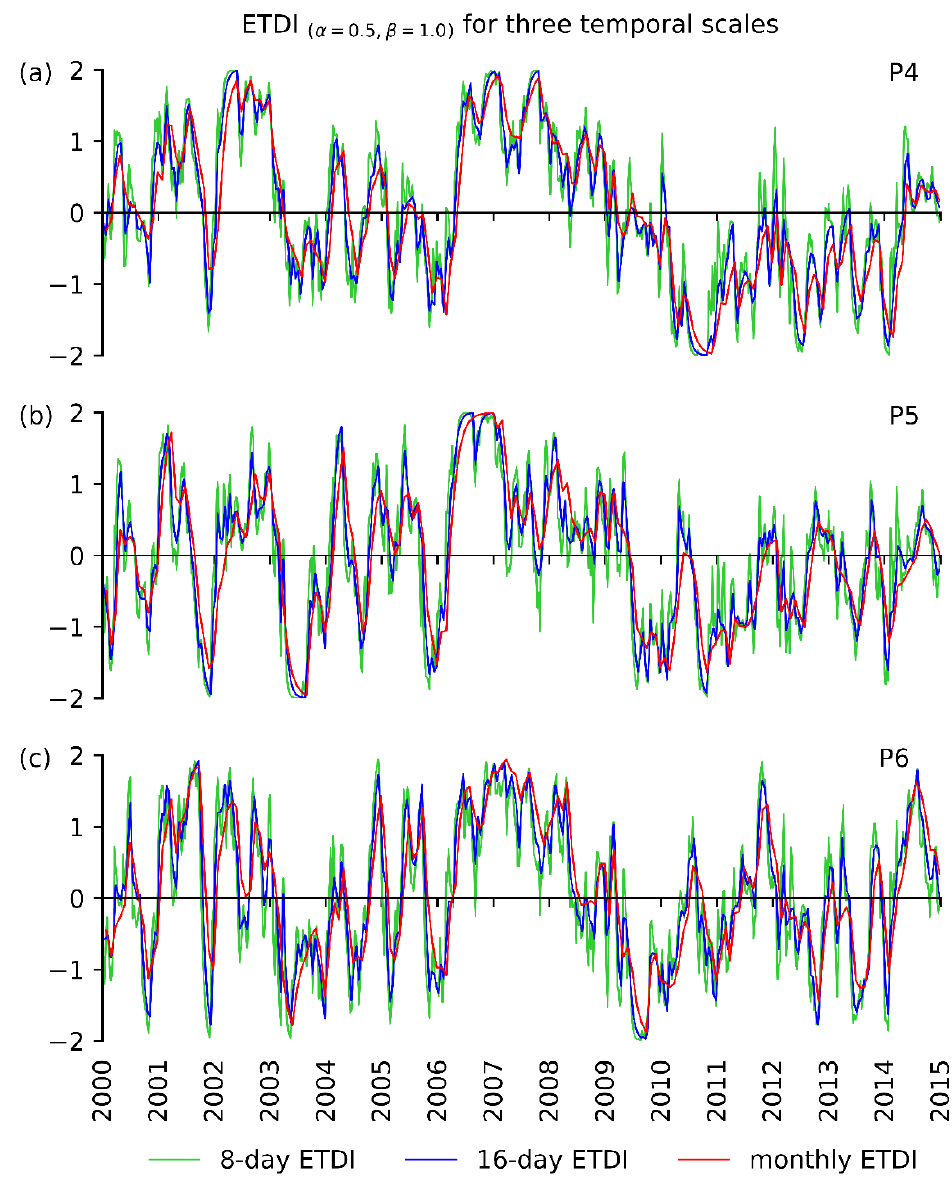
Figure 7. Evapotranspiration deficit index (ETDI) at 8-day, 16-day, and 1-month temporal scales at points P4 to P6 in the Ruvu River basin. Table 3. Drought events, total drought durations, and duration per event at points P1 to P12 at 8- day, 16-day, and 1-month temporal scales in the Ruvu River basin.